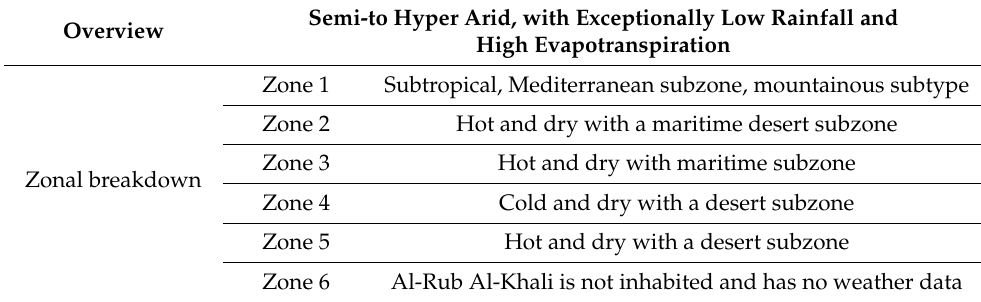
Table 2. Climate description and zonal breakdown of Saudi Arabia [8,14].